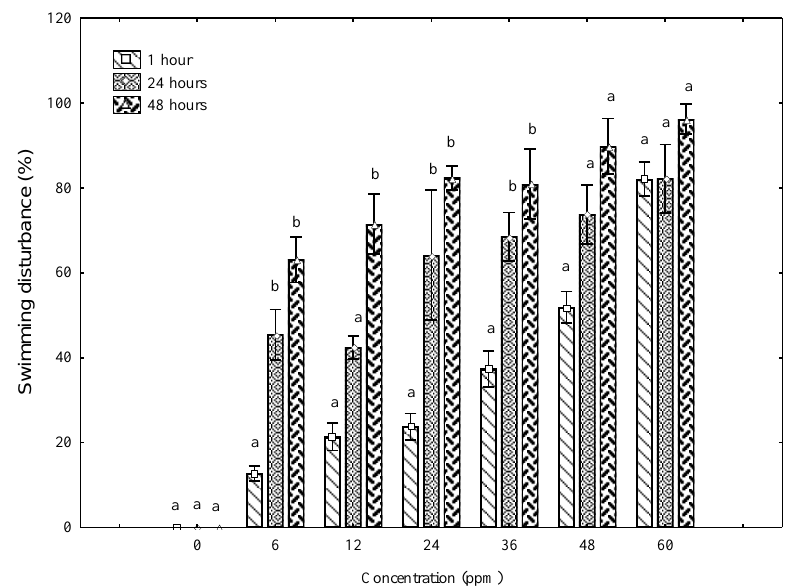
Figure 2. Distribution of swimming ability perturbation according to tested cypermethrin concen- trations and time. Error bars indicate average ± standard deviation. For each concentration, differ- ent heading letter indicate significant difference (ANOVA 1, p < 0.05).